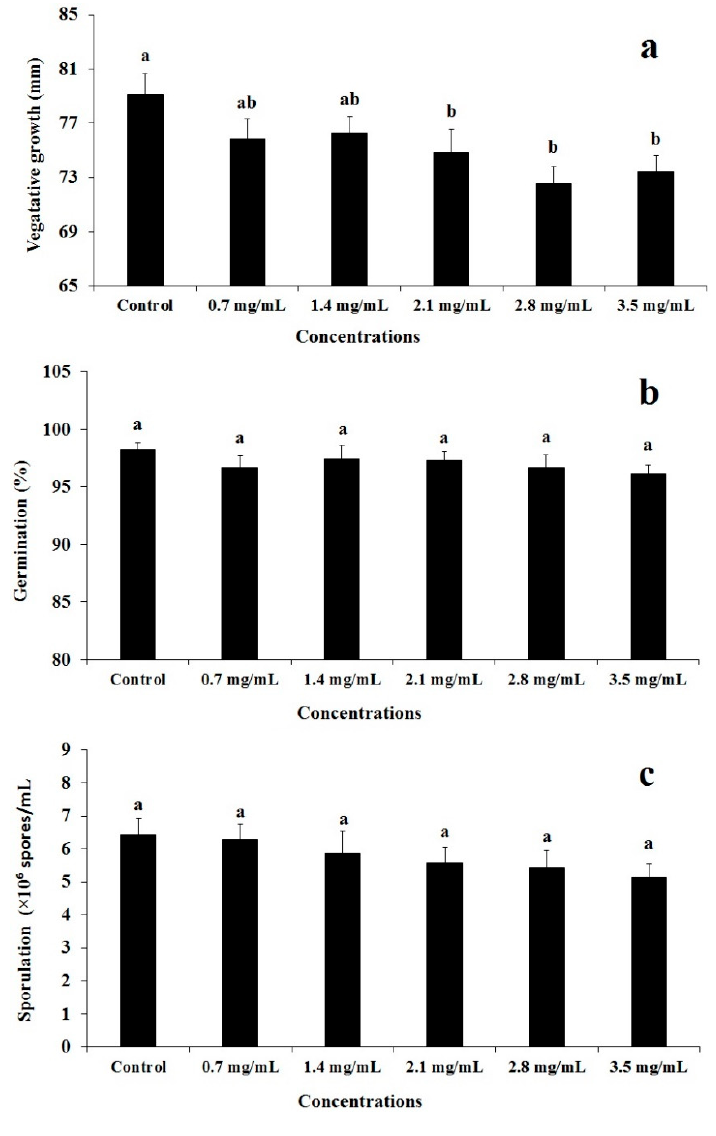
Figure 1. Effect of various concentrations of phytol prepared in DMSO on the vegetative growth ( a ), percent germination ( b ), and sporulation ( c ) of B. bassiana B6903. Values are the means of seven independent replicates. Bars with similar letter(s) are not significantly different (Fisher’s LSD test, α = 0.05).